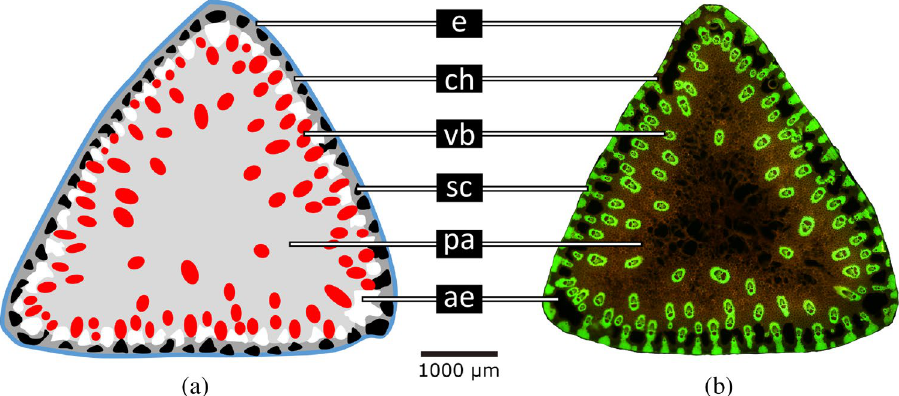
Figure 1. Internodal cross-section of the biological model Carex pendula . ( a ) Schematic drawing highlighting the tissues. ( b ) Thin-section stained with acridine orange revealing lignified tissues in bright yellow-green.